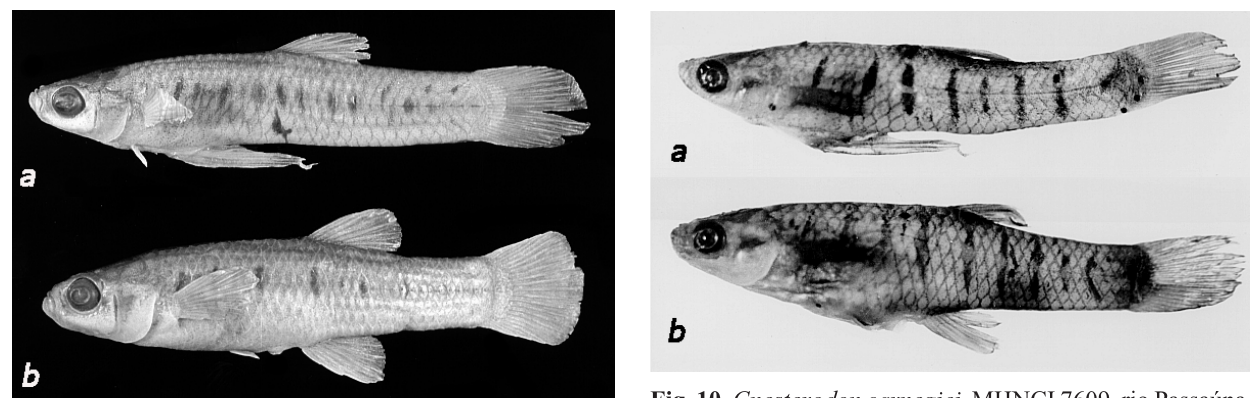
Fig. 10. Cnesterodon carnegiei . MHNCI 7609, rio Passaúna, Almirante Tamandaré, Paraná, Brazil: (a) male, 24.3 mm SL; (b) female, 30.1 mm